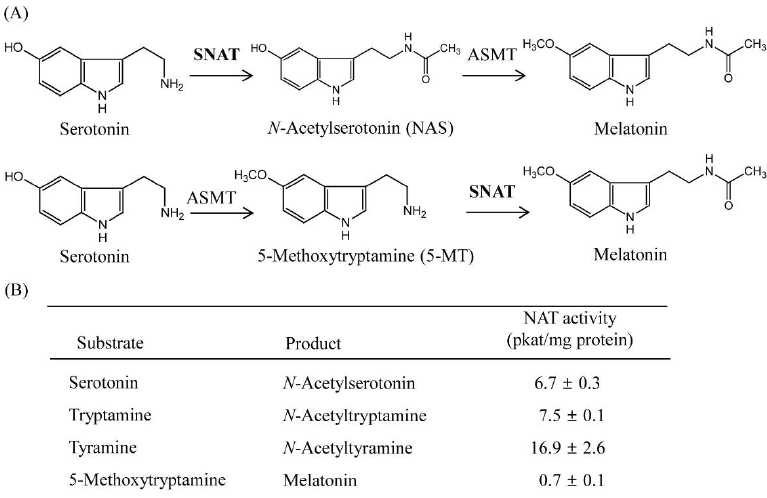
Figure 3. Schematic diagram of the SNAT reaction and substrate preference. ( A ) Enzymatic reaction of SNAT in two different melatonin biosynthetic pathways. ( B ) TvSNAT enzyme activity measurements for various substrates. SNAT enzyme activity was measured in the presence of 0.5 mM of each substrate at 45 °C and pH 8.8. Data are the means ± standard deviation ( n = 3). ASMT, N -acetylserotonin O -methyltransferase; SNAT, serotonin N -acetyltransferase.